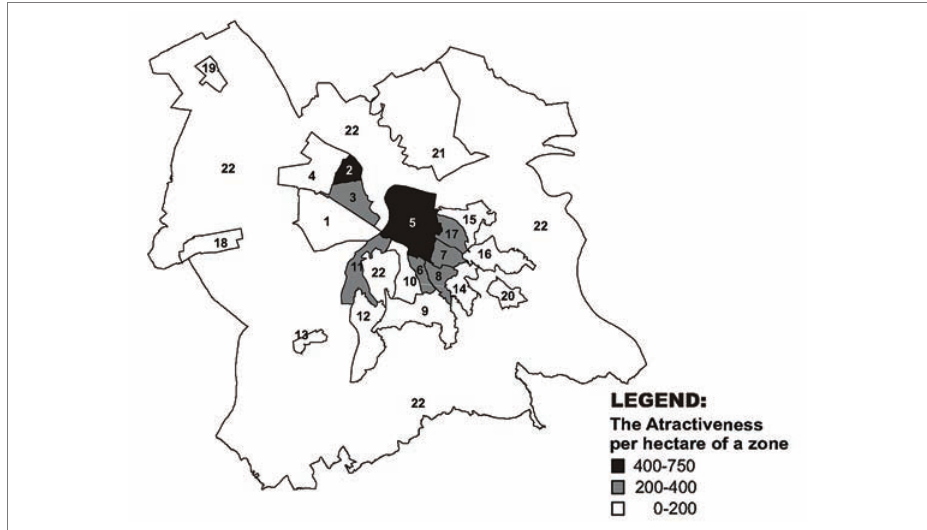
Fig. 1. Ranking of zones covered by the Study according to attractiveness